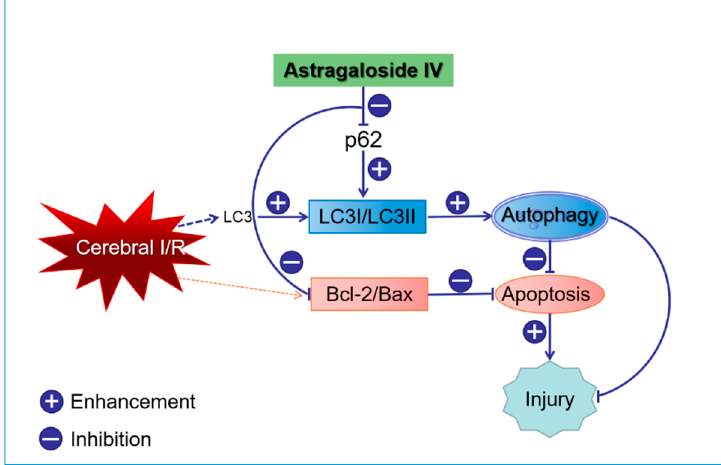
Figure 10. The neuroprotective mechanisms of Astragaloside IV against cerebral ischemia/reperfusion (I/R) injury.